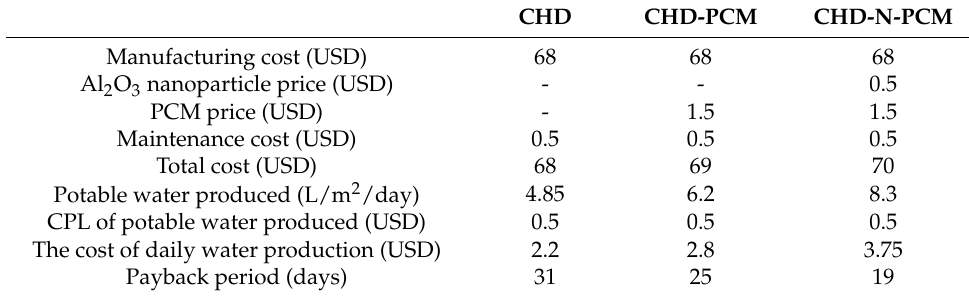
Table 7. Fabrication cost of CHD, CHD-PCM, and